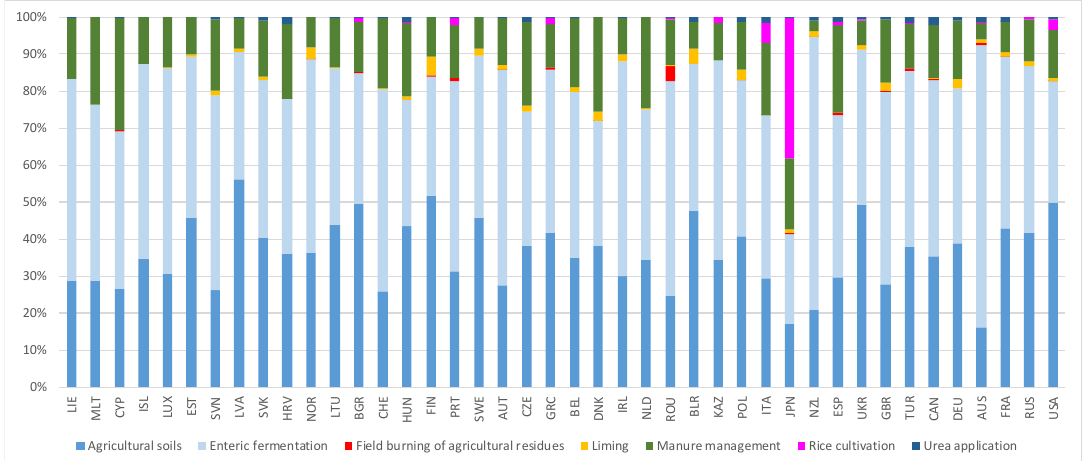
Figure 2. The shares of agricultural sources (from bottom to top: agricultural soils, enteric fermentation, field burning of agricultural residues, liming, manure management and urea application) in agricultural emissions in each Annex I country for 2017.